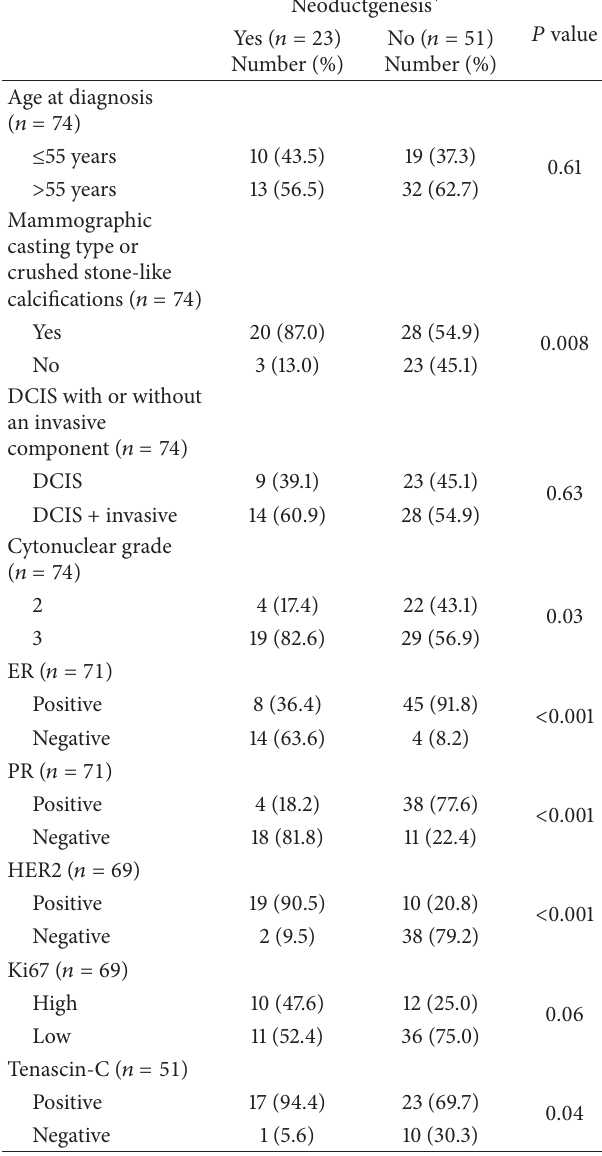
Table 4: The correlation between neoductgenesis and patient and tumour characteristics in 74 cases with intermediate (grade 2) or high (grade 3) DCIS with or without an invasive